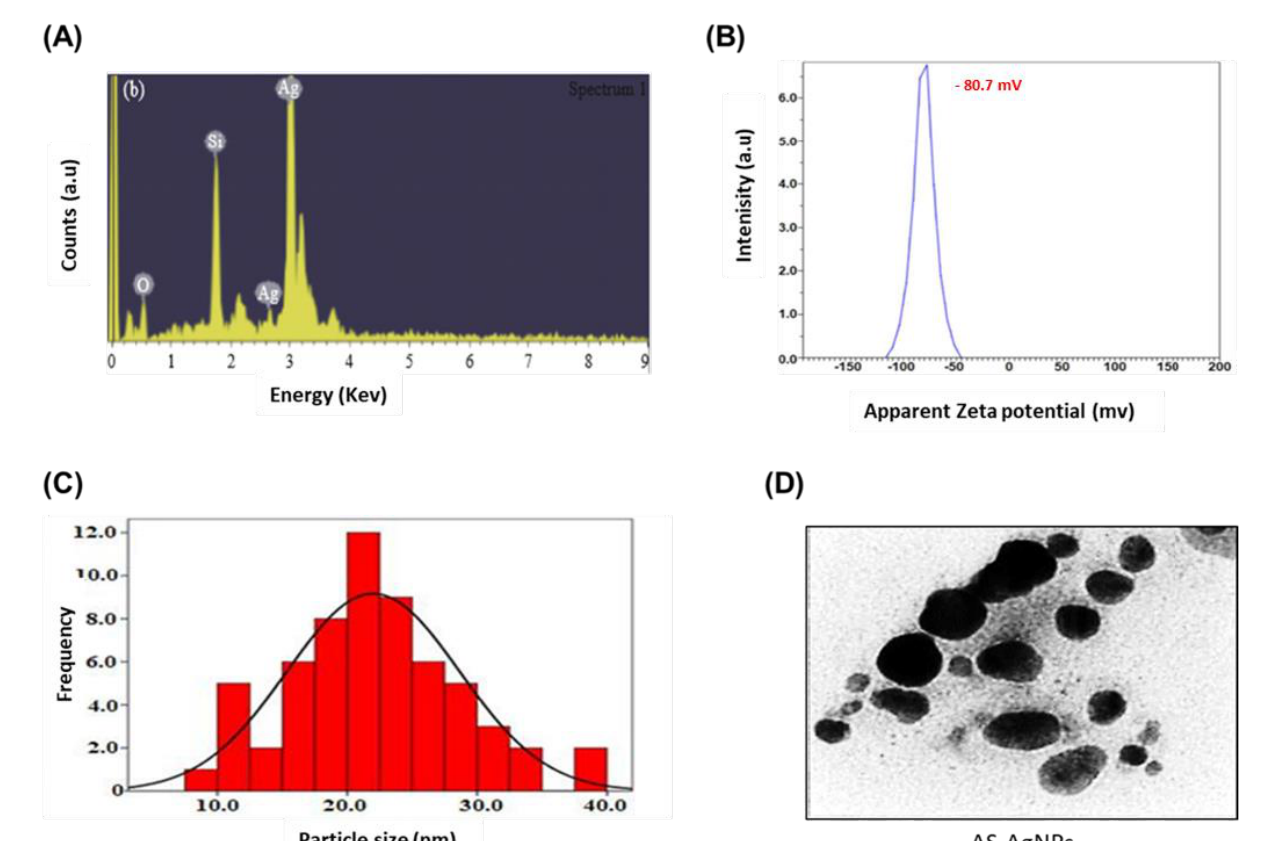
Figure 3. Characterization of green biosynthesized AS-AgNPs. ( A ) The EDX spectrum of silver nanoparticles synthesized by A. santolina showed a pattern of approximately 63.65% occurrence of Ag metal. ( B ) Zeta potential of silver nanoparticles synthesized by A. santolina . The value of zeta potential is − 80.7 mV. This value displays the high stability of A. santolina extract to synthesize AS-AgNPs. ( C ) The size distribution histogram of the dynamic light scattering (DLS) analysis of the biosynthesized AS-AgNPs. According to DLS analysis, this size distribution of AS-AgNPs is centered at 21.9 nm. ( D ) TEM micrograph of AS-AgNPs biosynthesized from A. santolina leaf extract. AS-AgNPs appeared spherical in shape with an average size of 21.9